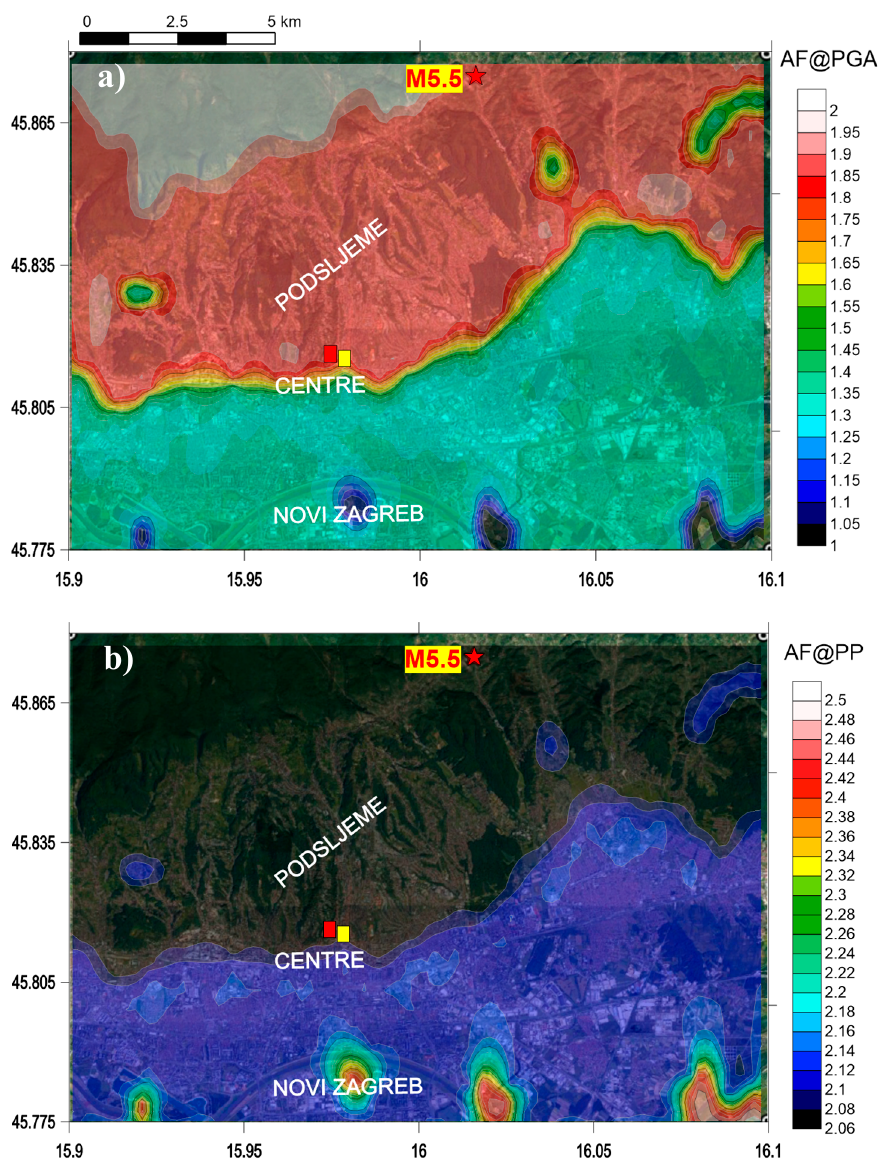
Figure 10. ( a ) Site amplification map for the PGA at surface (AF@PGA) and ( b ) the predominant amplification peak period (AF@PP) for estimated PGA ROCK .